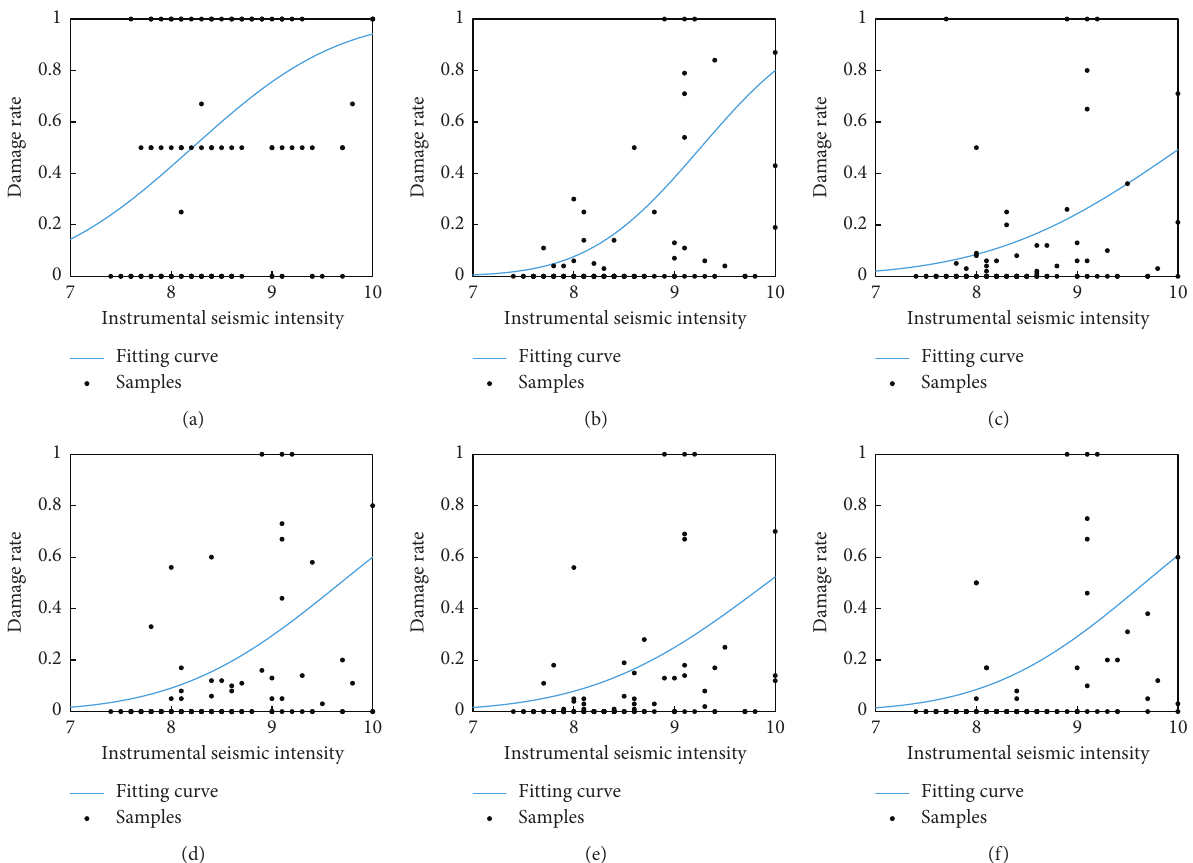
Figure 2: Damage rate fitted curves and samples distribution of high-voltage electrical equipment. (a) Transformer. (b) Circuit breaker. (c) Isolating switch. (d) Lightning arrester. (e) Current mutual inductor. (f) Voltage mutual inductor.